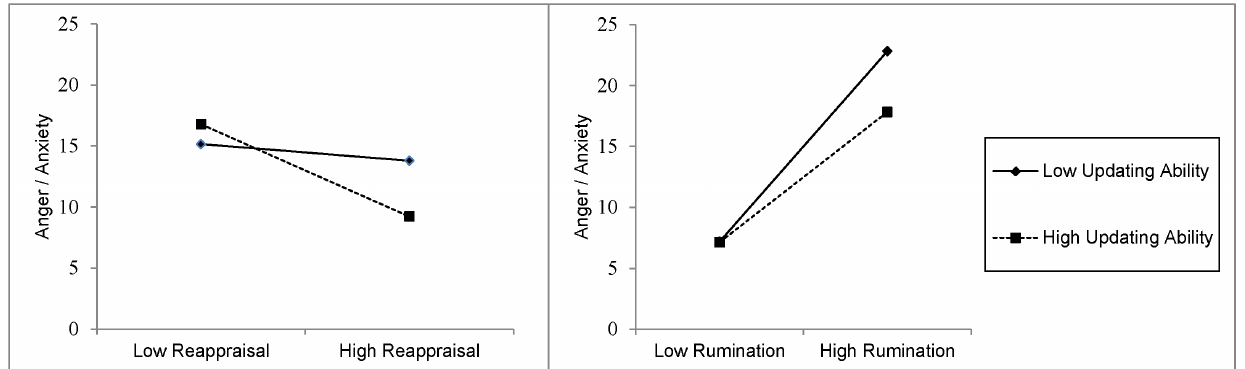
Figure 2. Illustration of the moderating effect of overall updating ability (as measured by the emotional n-back) on the relationship between reappraisal (left panel) and rumination (right panel) on anger/anxiety emotional experience (high arousal negative emotions) in daily life. Dashed and straight lines represent participants with low (-1 SD ) and high ( + 1 SD ) n -back scores, respectively. Low and high reappraisal scores are -1 SD and + 1 SD from the overall mean, respectively. Low and high rumination scores were coded